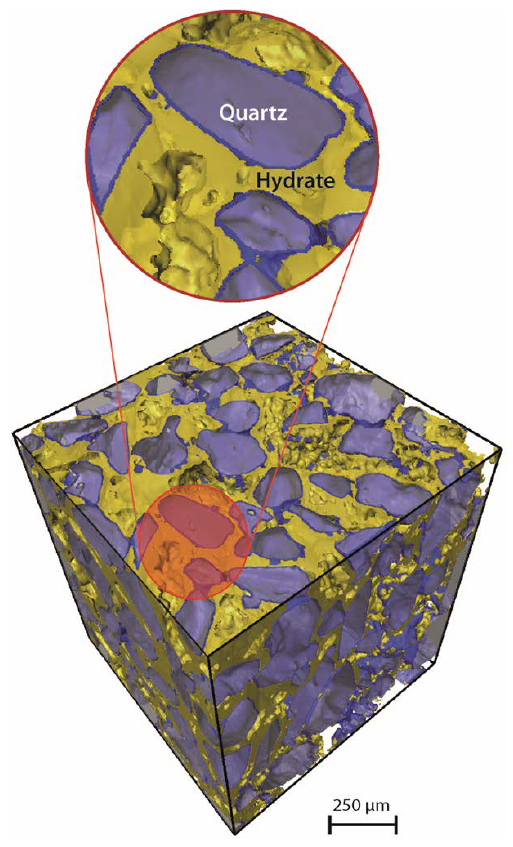
Figure 5. Volume-rendered image of a representative region of in- terest (ROI) of 600 × 600 × 600 voxels at 0.38µm spatial resolution. The zoom-in depicts quartz grains fully separated from the pore- filling hydrate by thin interfacial water films, with two quartz grains having their water films interconnected by a water